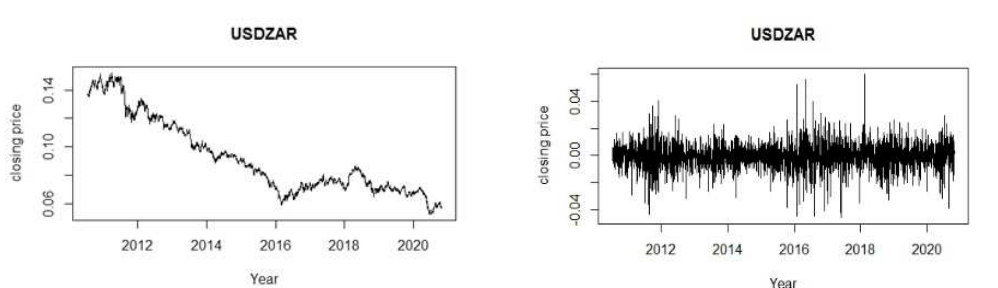
Figure 4. Time series plot of USD/ZAR exchange rate prices (left) and one-day returns (right)